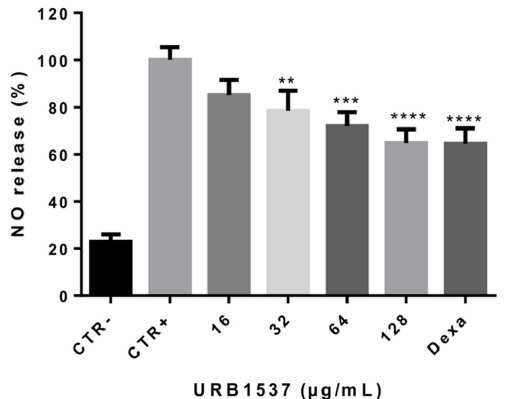
Figure 3. Extracellular NO release after RAW 264.7 stimulation by LPS for 24 h in the presence of